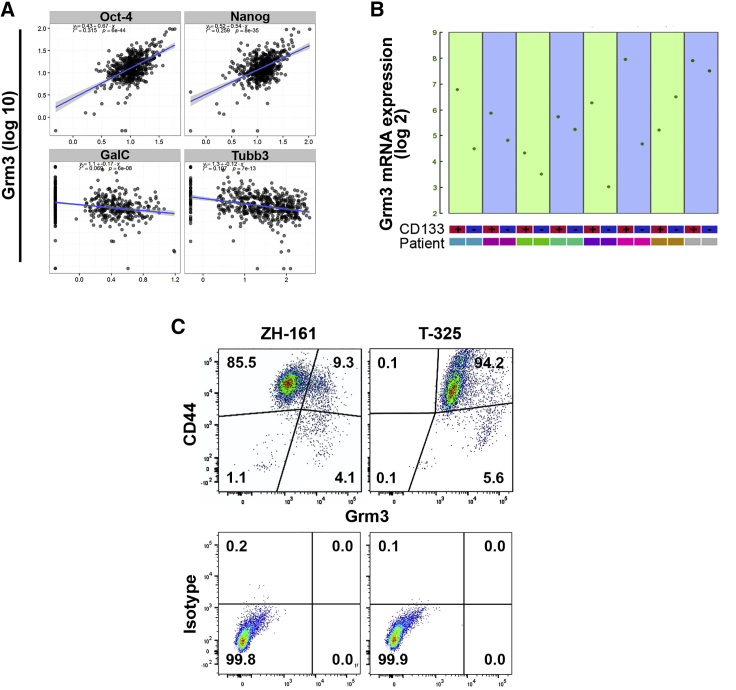
Grm3 expression in glioma-initiating cells(A) qRT-PCR in single cells (N = 482) derived from freshly dissociated human glioblastomas (N = 6, Table S1). x axis: gene expression of indicated genes. y axis: GRM3 gene expression. Slopes of blue lines indicate correlations. (B) GRM3 gene expression sorted for CD133 and analyzed by Affymetrix U133 Plus 2 arrays in a publically available dataset.17 (C) Flow cytometry of indicated GSCs utilizing fluorescence-labeled antibodies to Grm3 and CD44 or immunoglobulin G (IgG) isotype controls. Numbers in gates indicate percentages.